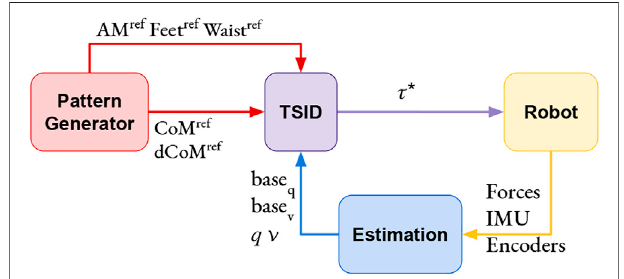
FIGURE 3 | TSID torque control